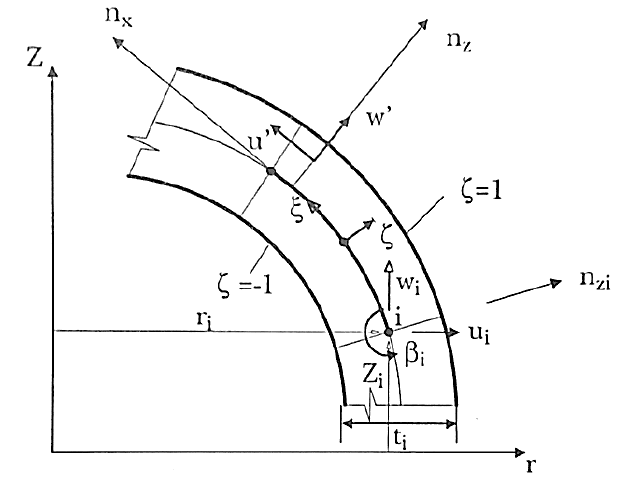
Figure 27. Asymmetric shell element. Reproduced with permission [75] .